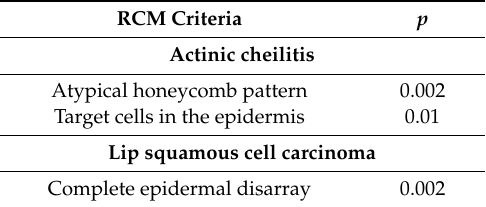
Table 6. Blood vessels characteristics of patients with AC and lip SCC.